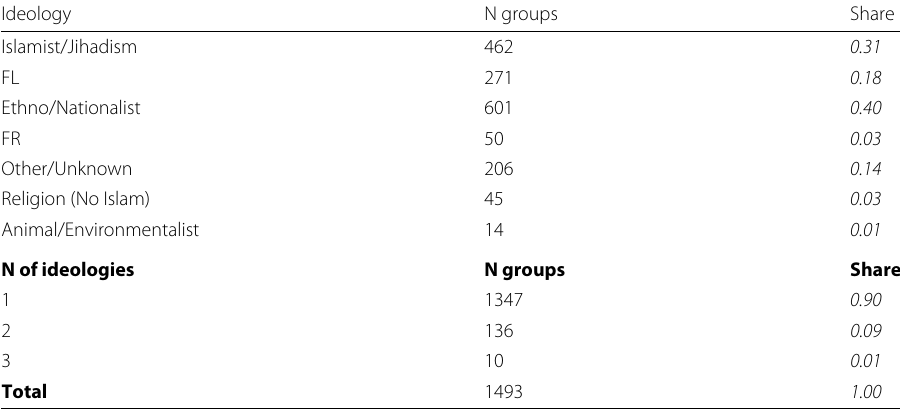
Table 1 Descriptive Statistics of Group Ideologies